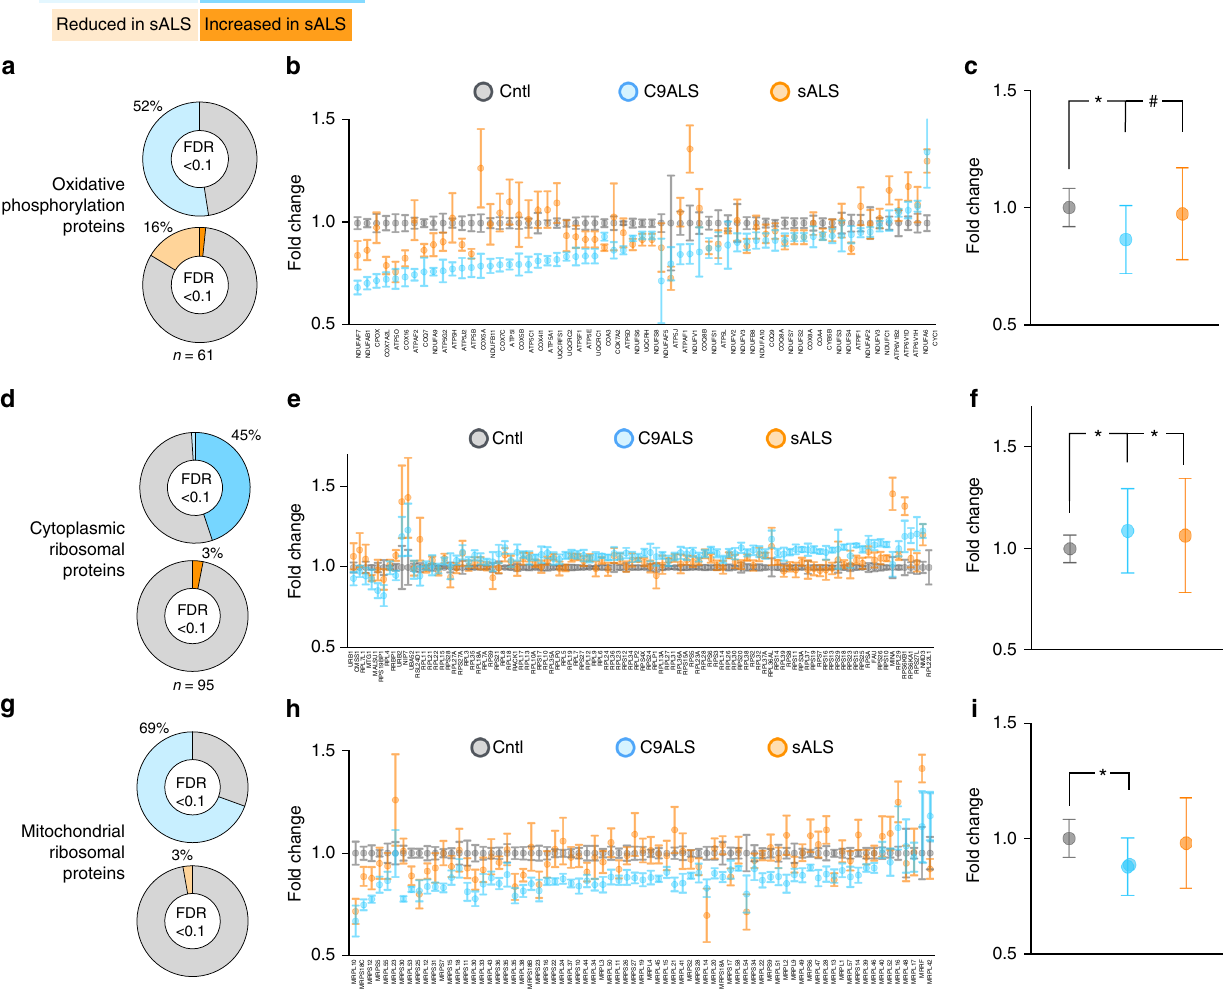
Fig. 5 Reduced abundance of mitochondrial proteins in C9ALS iPSCs. a Of the oxidative phosphorylation proteins detected by MS ( n = 61), 52% were signi fi cantly reduced in C9ALS iPSCs, and 16% were similarly reduced in sALS iPSCs compared to controls (Cntl). b Fold change in each of 61 oxidative phosphorylation proteins. c Cumulative change in the abundance of oxidative phosphorylation proteins in ALS iPSCs. d 45% and 3% of the 95 cytoplasmic ribosomal proteins detected by MS in ALS iPSCs were signi fi cantly increased in C9ALS and sALS iPSCs, respectively, compared to controls. e Fold change for the 95 cytoplasmic ribosomal proteins in ALS iPSCs. f Cumulative change in the abundance of cytoplasmic ribosomal proteins in ALS iPSCs. g 72 separate mitochondrial ribosomal proteins were detected by MS in ALS iPSCs; 69% and 3% were reduced in abundance in C9ALS and sALS iPSCs, respectively. h Fold change for the 72 mitochondrial ribosomal proteins in ALS iPSCs. i Cumulative change in the abundance of mitochondrial ribosomal proteins in ALS iPSCs. FDR false discovery rate. All experiments performed in triplicate, with two lines /condition. Plots in c , f , i show mean ± standard deviation. * p < 0.0001; # p < 0.05, one-way ANOVA with Benjamini − Hochberg correction for multiple